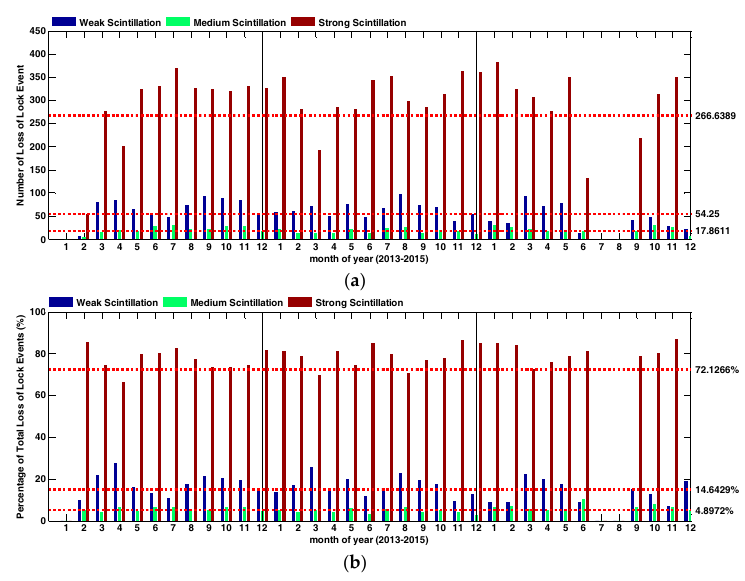
Figure 1. Temporal statistics of loss of lock events ( a ) and percentage; ( b ) occurred under ionosphere scintillation.